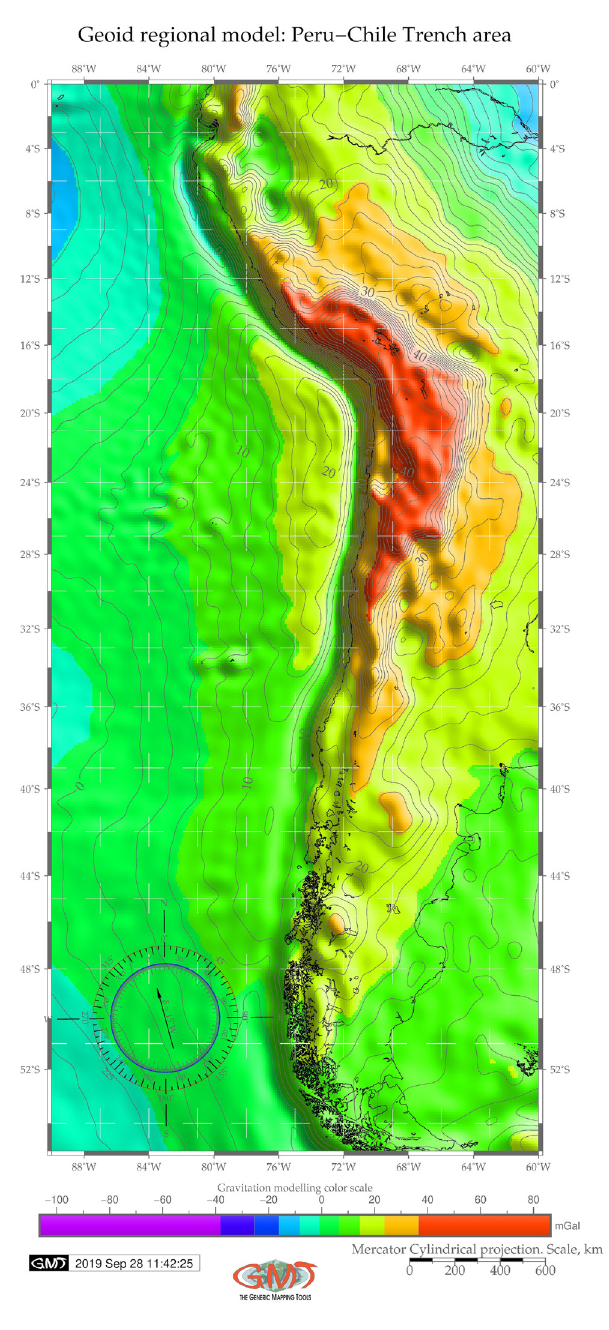
Fig. 3. Geoid model map of the Peru-Chile Trench